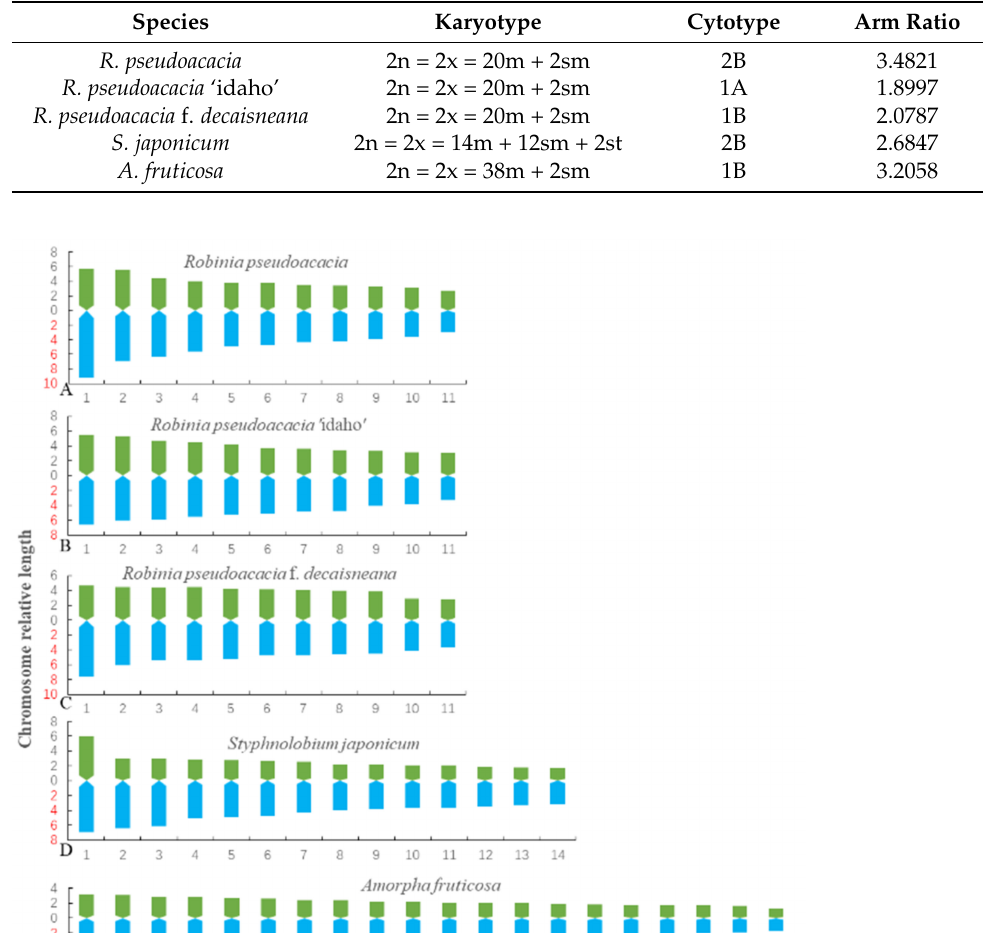
Figure 2. Mitotic chromosomes of five Fabaceae rearranged from Figure 1. ( A ) R. pseudoacacia , ( B ) R. pseudoacacia ‘idaho’, ( C ) R. pseudoacacia f. decaisneana . ( D ) S. japonicum , and ( E ) A. fruticose . According length, the chromosomes were aligned from the longest to the shortest chromosome. The scale bars range from 1 to 4 µ m. Table 2. Karyotype analysis of five Fabaceae. Relative chromosome length of five Fabaceae was omitted. Karyotype asymmetry index, according to Stebbins (1971).